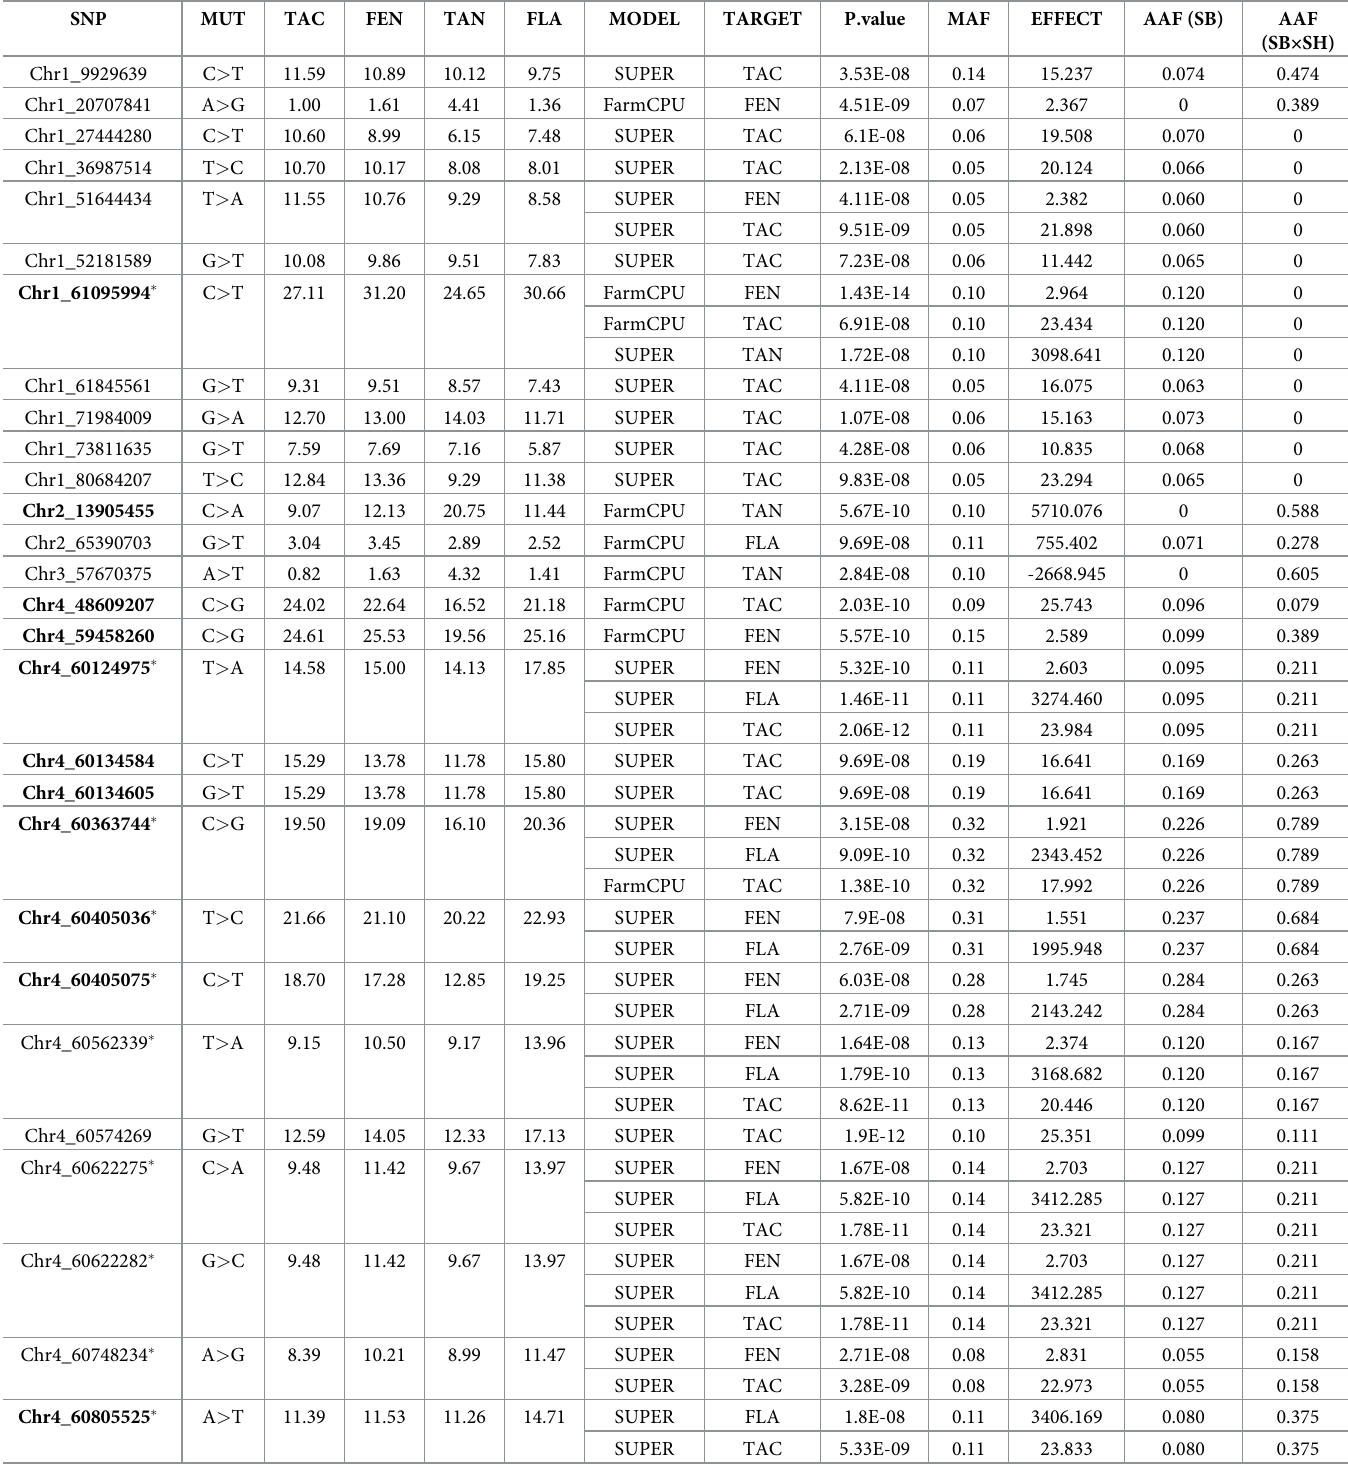
Table 2. GWAS results and descriptive statistics of the significant marker